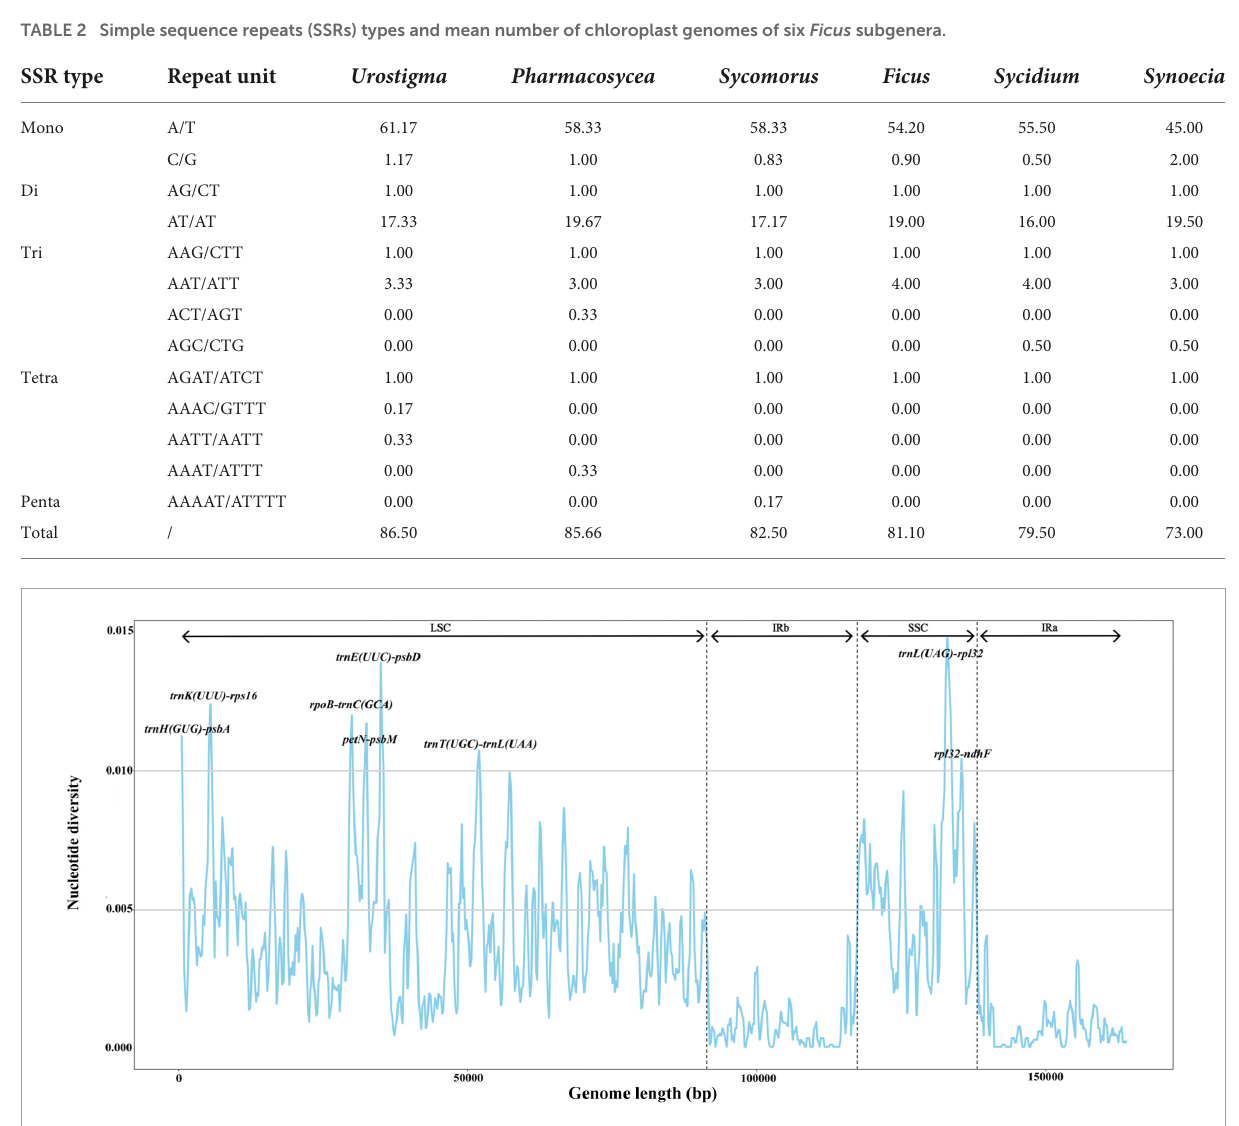
FIGURE2 Nucleotide diversity ( π ) by sliding window analysis in the multiple alignments of 24 Ficus plastomes. Window length: 600 bp, step size: 200 bp. X -axis: the position of the midpoint of a window. Y -axis: the nucleotide diversity of each